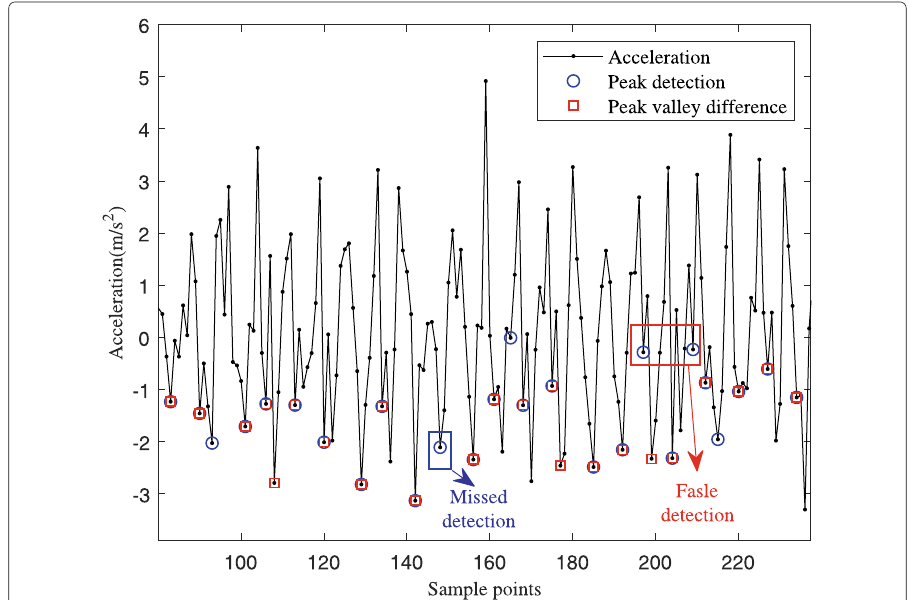
autocorrelation detection. Take valley detection as an example, the blue circle in Fig. 2 is the step counting result corresponding to a certain acceleration sampling value. As can be seen from Fig. 2, the collected acceleration data fluctuates violently due to noise, which will cause the wrong step detection. In order to eliminate the interference caused by noise, researchers often add new detection elements, such as time interval, peak valley diffe-